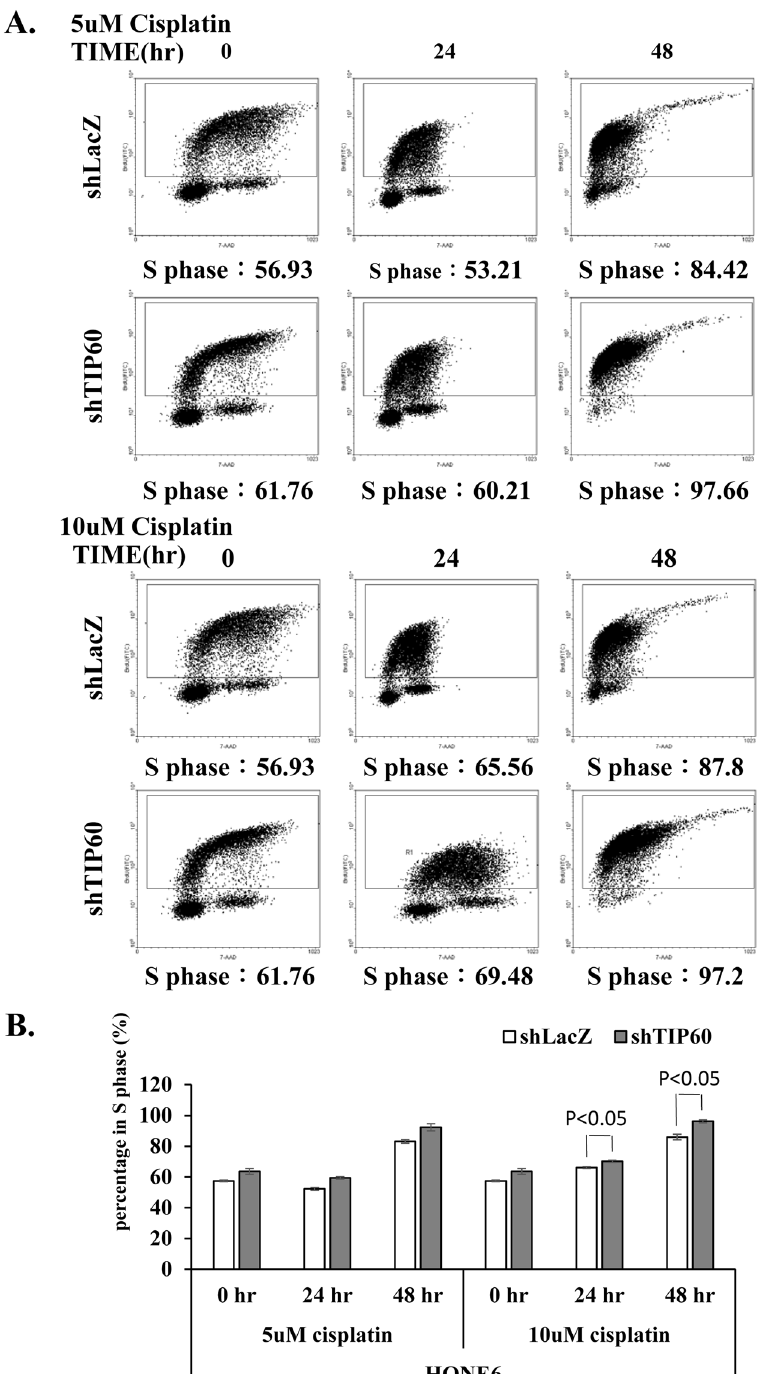
Figure 4. The TIP60-deficient cells accumulated significantly more cells in S-phase than the TIP60- proficient cells in 10 μ M cisplatin. ( A ) Cells were chronically treated with 5 μ M or 10 μ M cisplatin for 24 or 48 hours. Fractions of the S phase cells were determined by the flow cytometry. ( B ) Each value represents the mean ± standard deviation from two independent experiments. The significant difference between the control LacZ and the shTIP60 HONE6 cells was indicated, with a p-value < 0.05 (Student’s